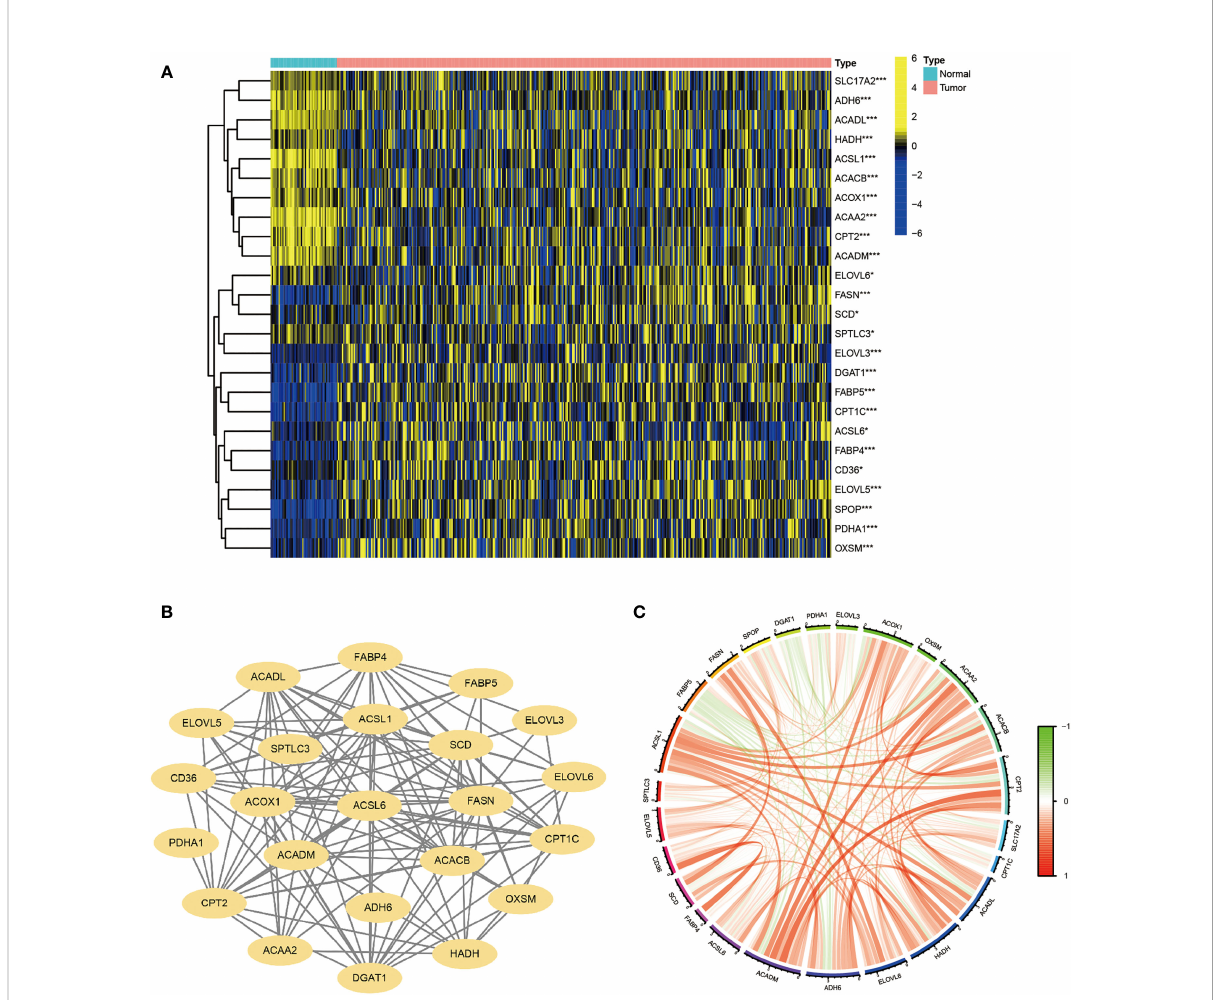
FIGURE 1 Identi fi cation of FA Metabolism-Related DEGs between Normal and HCC Tissues. The landscape of FA metabolism-related genes of HCC patients from TCGA database. (A) Heatmap showed DEG expression in two different tissues. (B) PPI network of the interactions. (C) The correlation network of these genes (*p < 0.05, **p < 0.01, ***p <